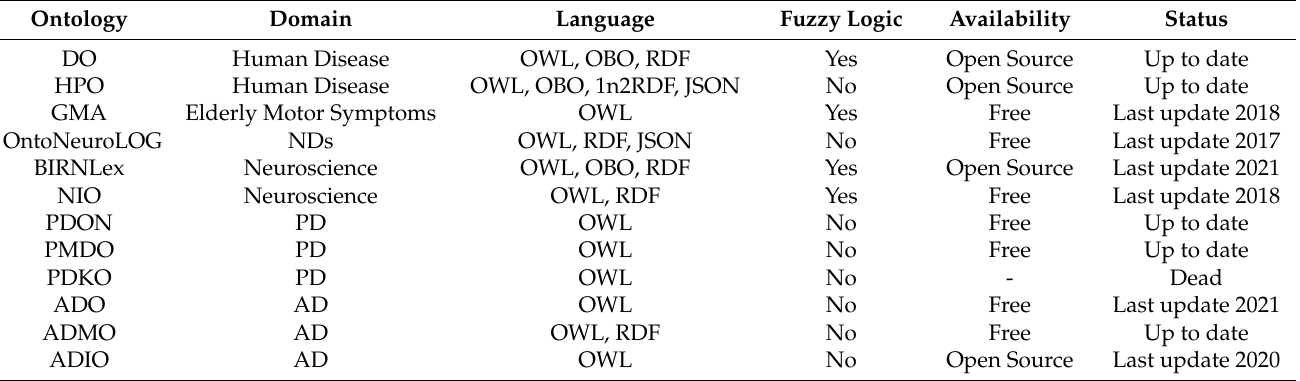
Table 1. Comparative table of reviewed